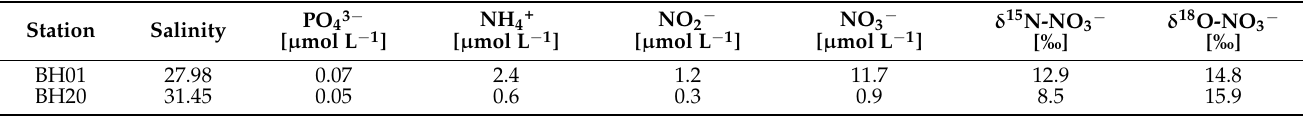
Table 1. Endmember parameters, including salinity, nutrient concentrations and dual nitrate isotope values, used in the two-endmember mixing model in Equations (5)–(7). Station BH01 represents water at the head of nearshore areas and station BH20 represents water carried into coastal areas from the water further out to